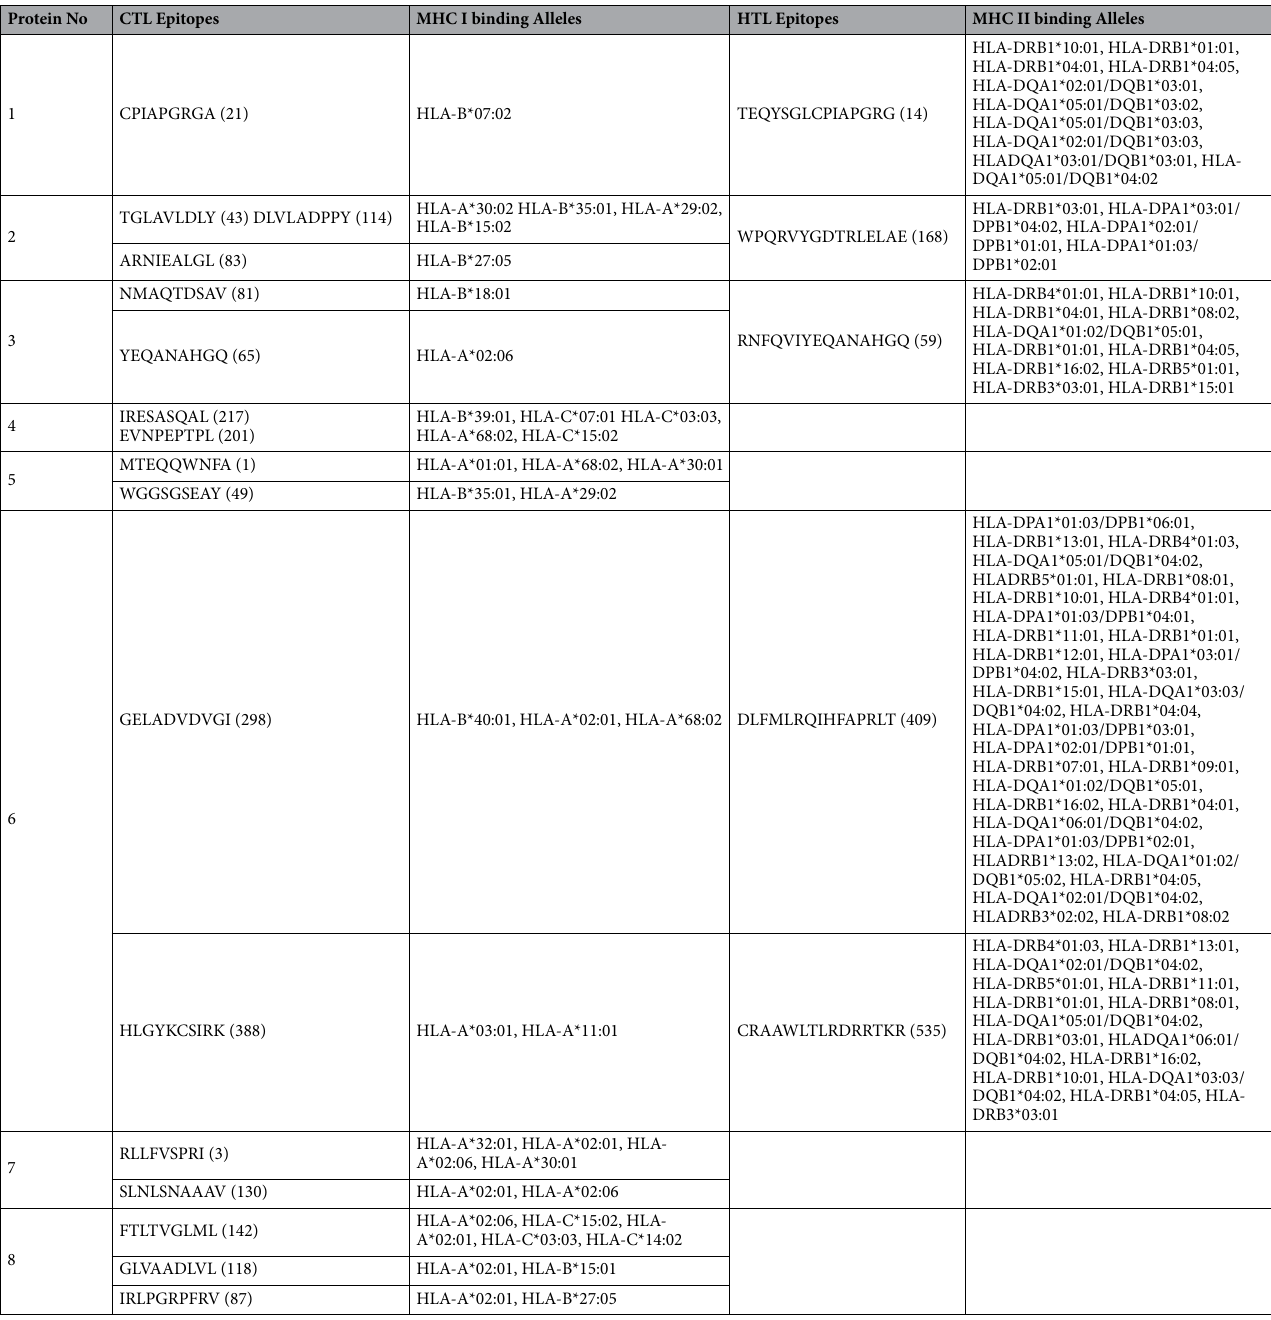
Table 2. Selected T lymphocyte epitopes (CTL + HTL epitopes) and their corresponding MHC alleles.